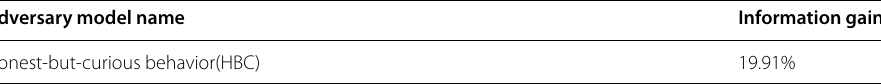
Table 7 Information